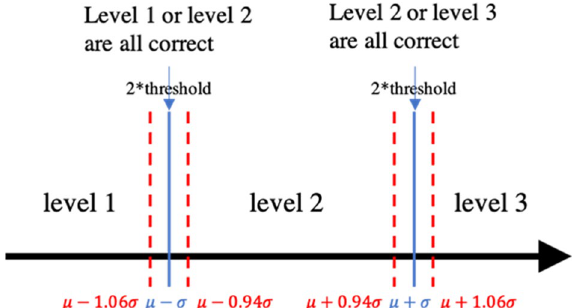
Figure 5. The relaxed morphological feature classification evaluation rule with the tolerance threshold. The tolerance threshold was set at 0.06 σ , and classifying an image with percent atrophy µ − 1.06 σ to µ − 0.94 σ , µ − 0.06 σ to µ + 0.06 σ , and µ + 0.94 σ to µ + 1.06 σ either to its ground-truth or adjacent level were considered as a correct